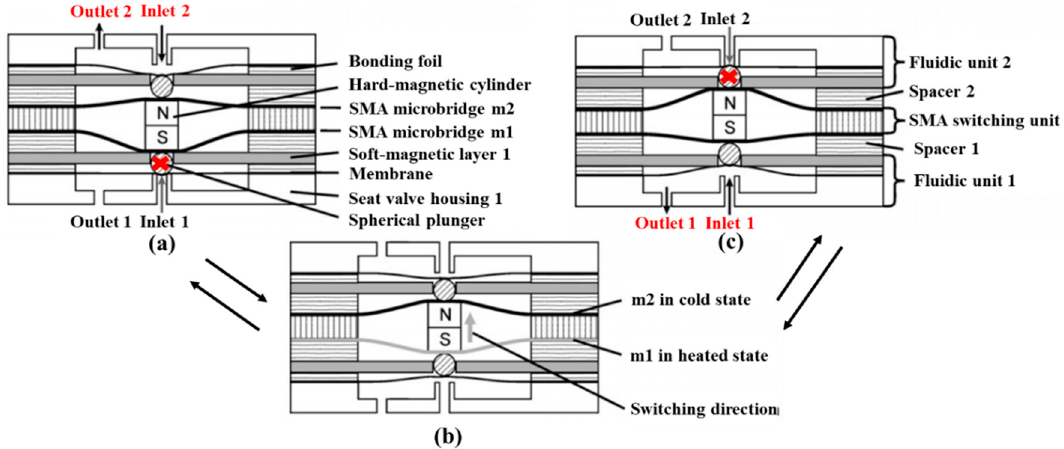
Figure 18. Schematic cross-section of the three-way bistable SMA microvalve [108]: ( a ) State I; ( b ) Switching state; ( c ) State II. (b) Switching from state I to state II is performed by directly heating microbridge m1 with an electrical current. Table 7. Comparison of typical high flow microvalves.